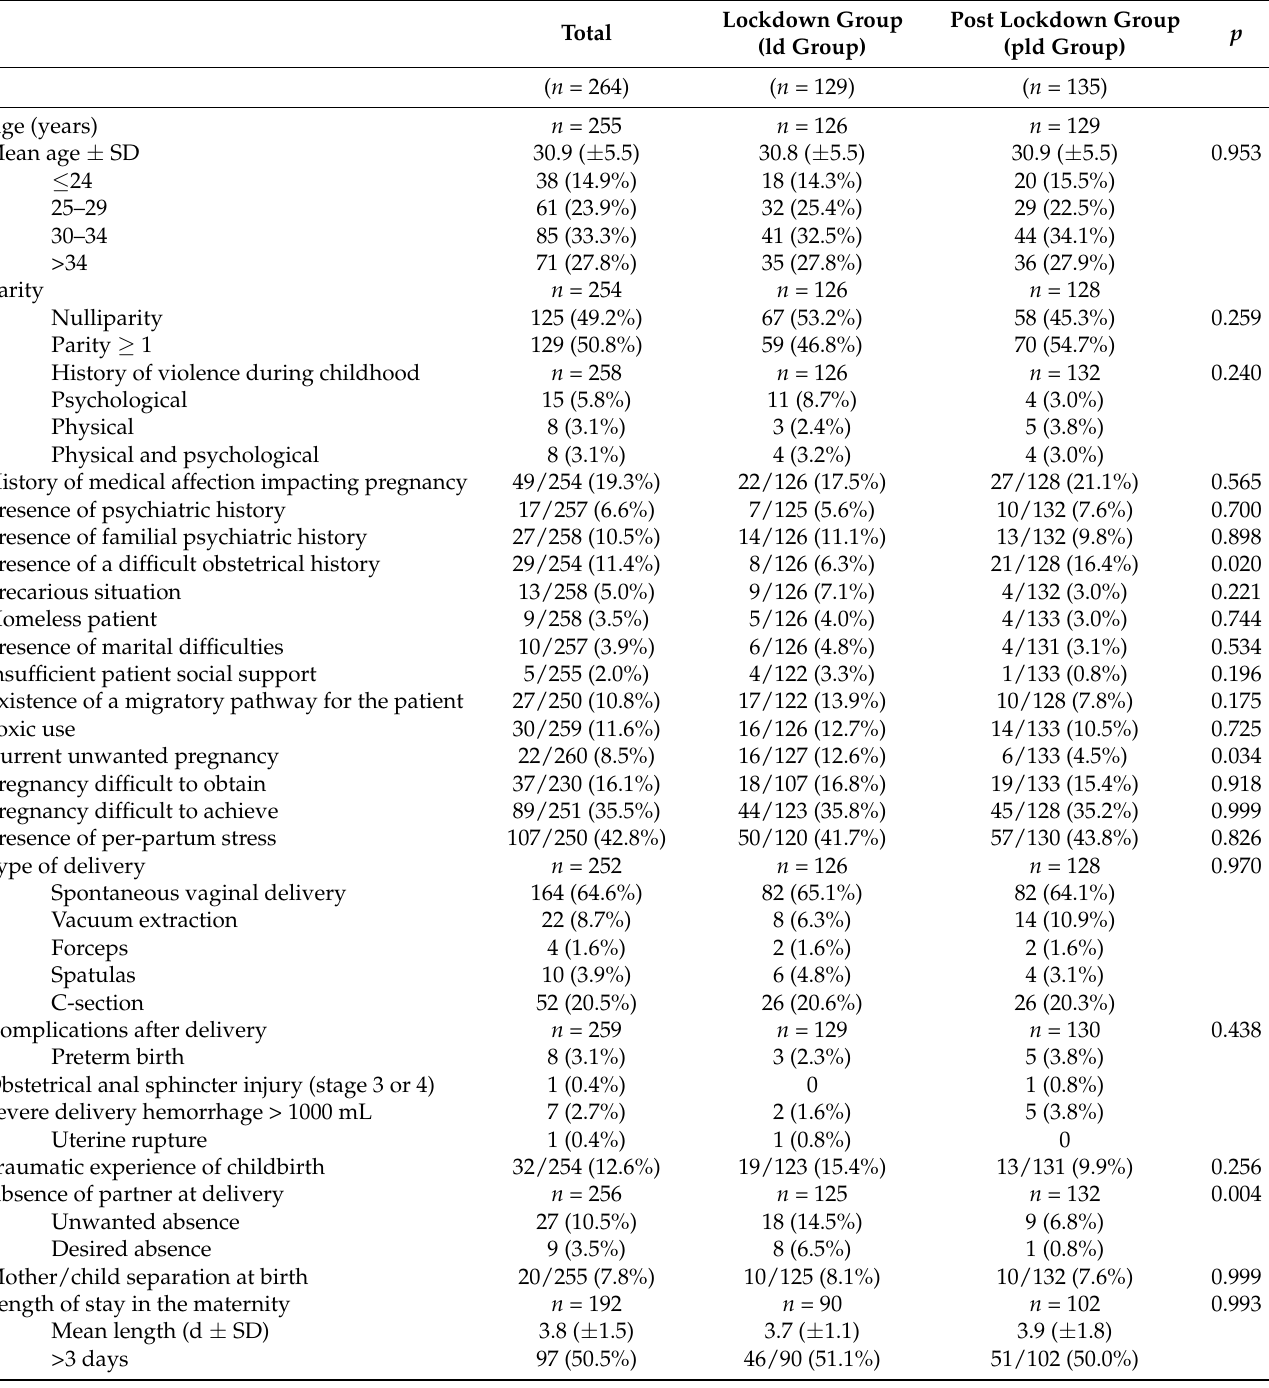
Table 1. Risk factors of Postpartum